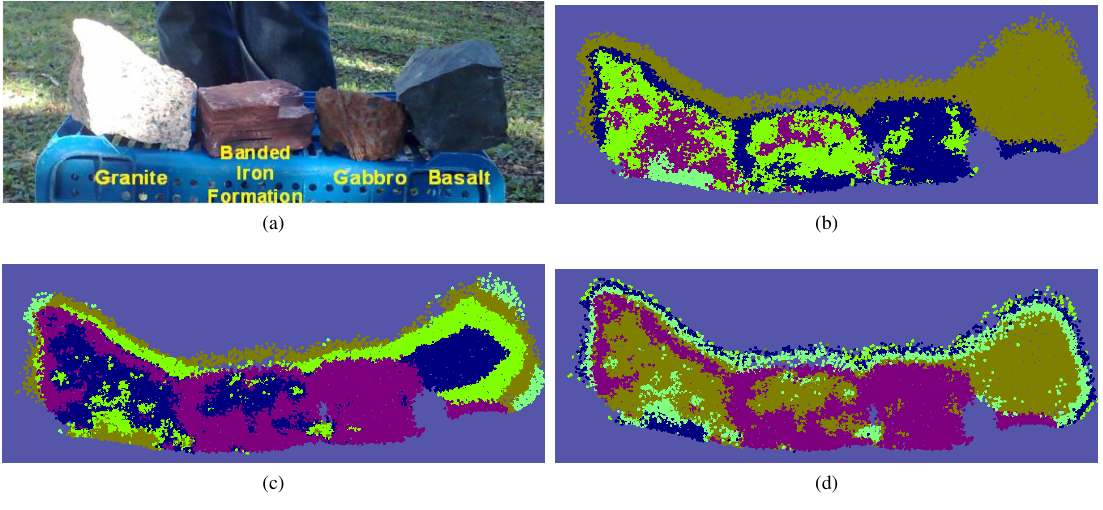
Figure 6: (a) Rock samples, includes granite, banded iron formation, basalt and gabbro; (b) rock samples before running the algorithm to correct the intensity data; (c) Clustered rock samples after running the algorithm to correct the intensity data; (d) Clustered rock samples after running the algorithm to correct the intensity data with different set of parameters.